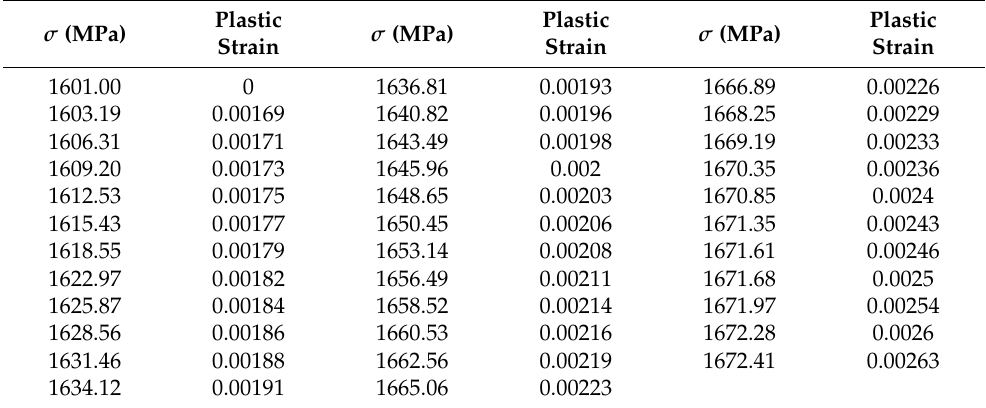
Table 5. Plastic material data of the steel